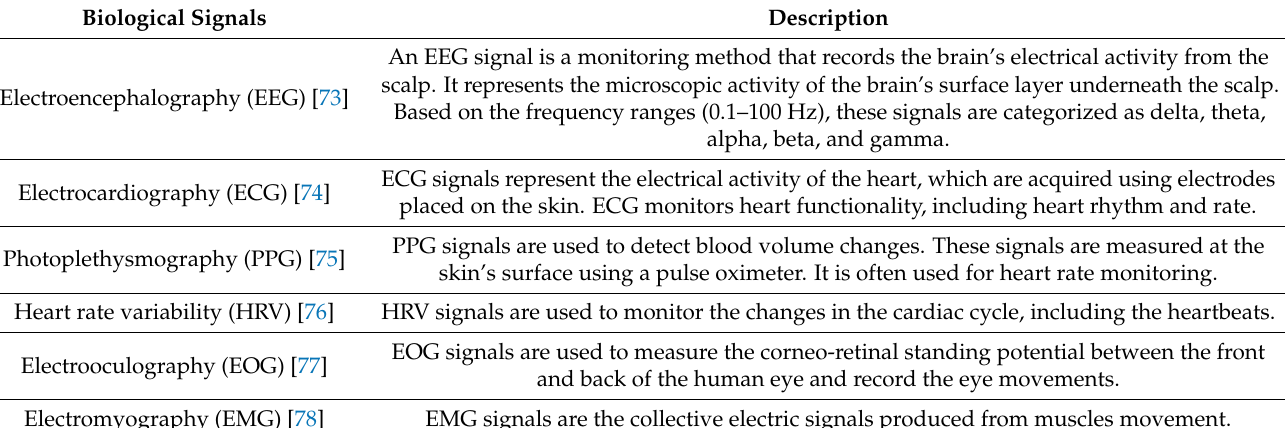
Table 5. Some biological-based